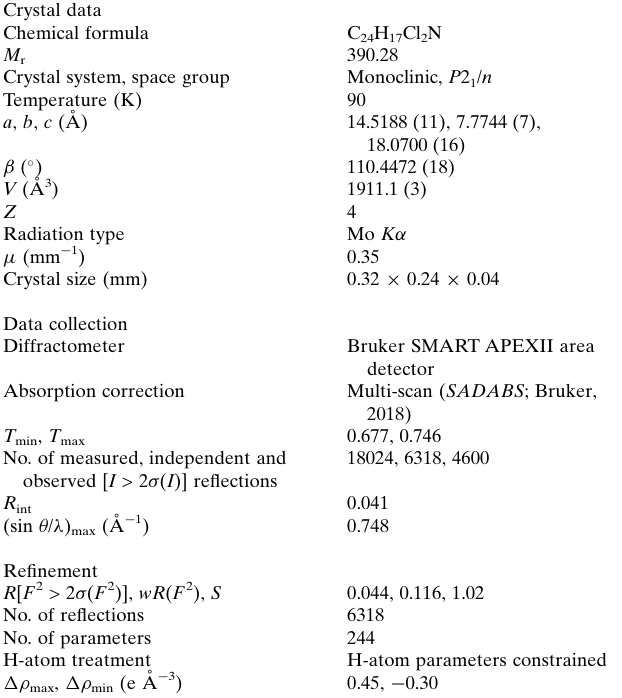
Crystal data Chemical